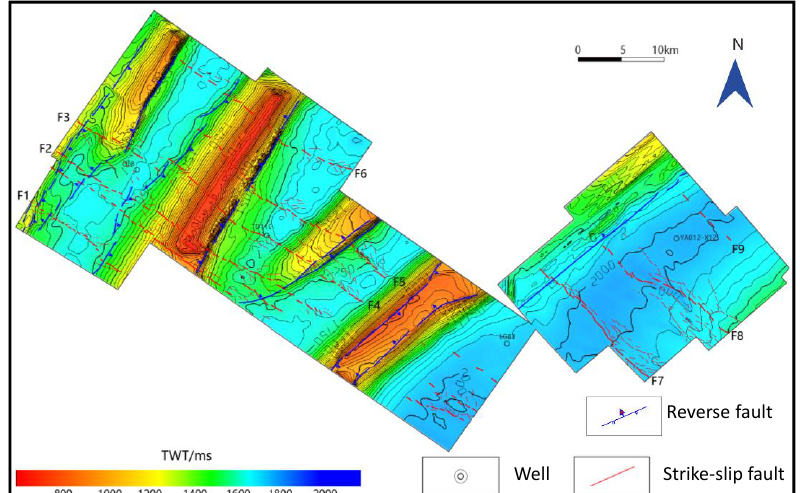
Figure 5. The strike-slip fault distribution in the Triassic of this study area.